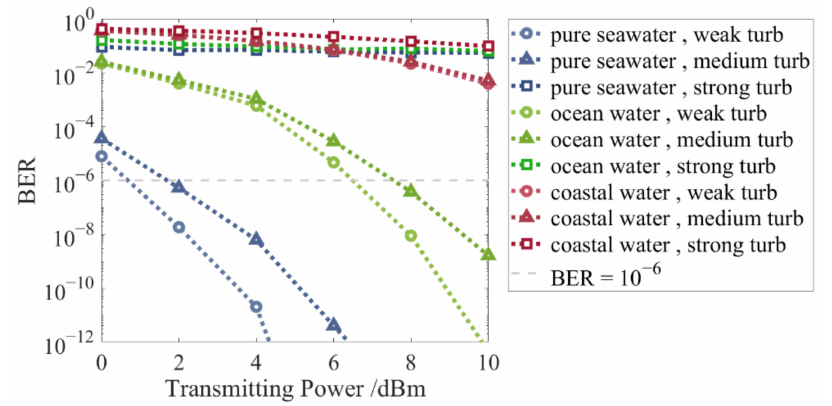
Figure 13. BER of the UWOC system under different absorption, scattering, and turbulence